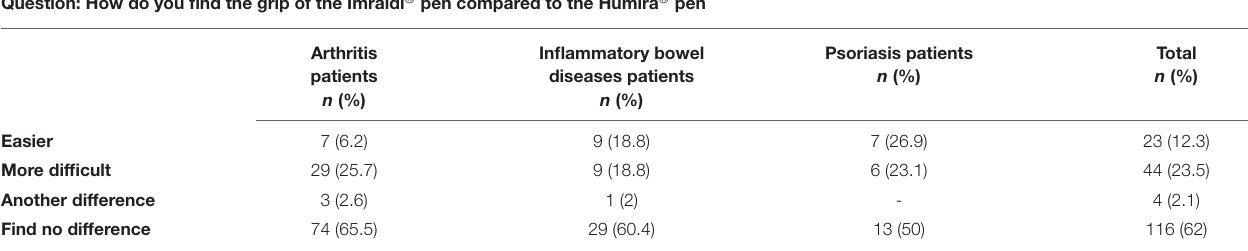
TABLE 3 | Patients’ comparison of the differences of the grip between the Imraldi ® and the Humira ® pens. Question: How do you find the grip of the Imraldi ® pen compared to the Humira ® pen Arthritis